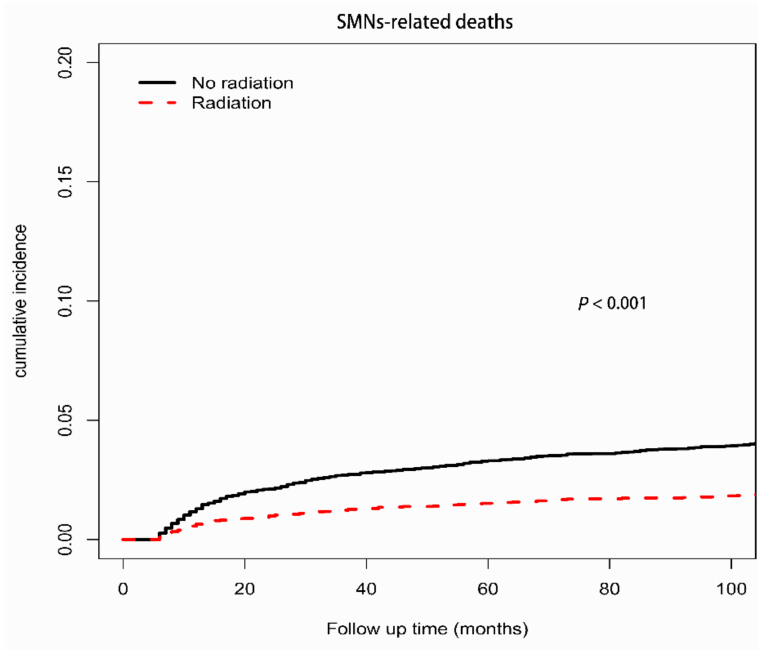
Figure 2. Cumulative incidence curves of death from SMNs among AYA patients, RT vs. no